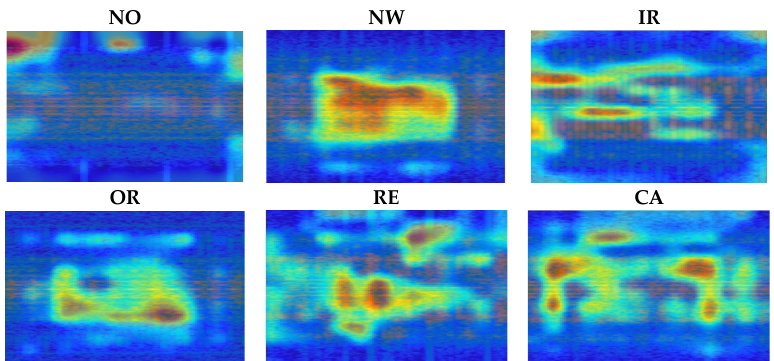
Figure 19. Examples of the generated Grad-CAM activation maps for the STFT-based vibration images produced from the bearing vibration signals with six health conditions in Figure 18.